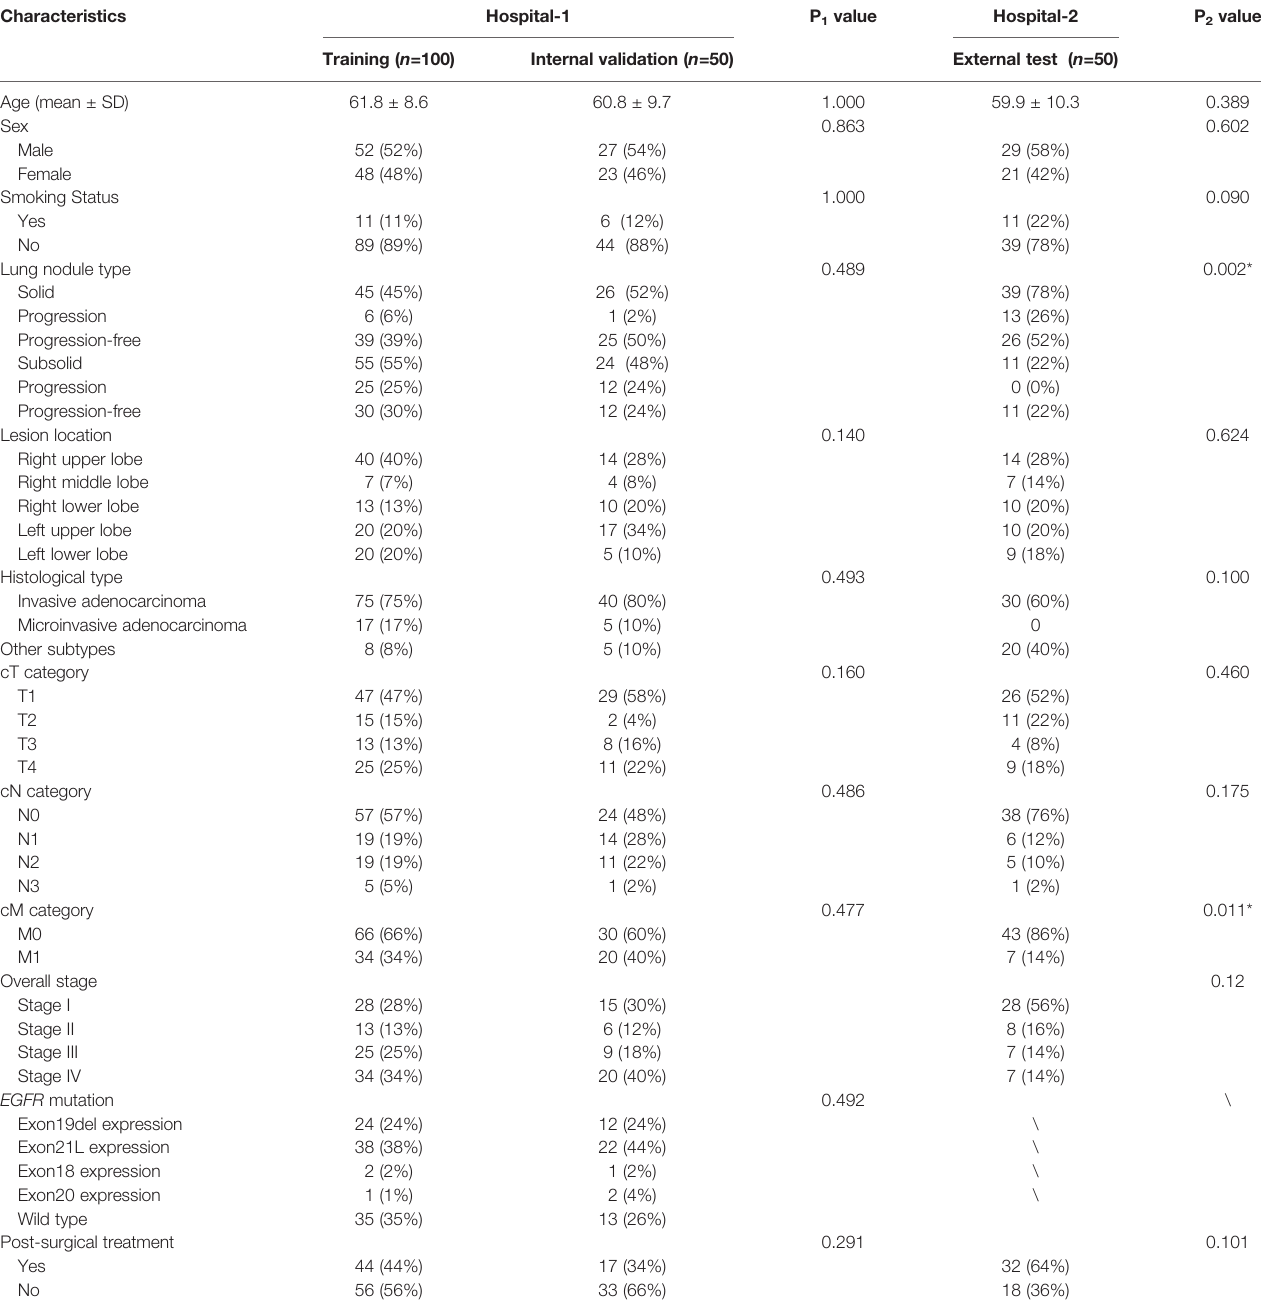
TABLE 1 | Association between patient characteristics and progression-free survival.